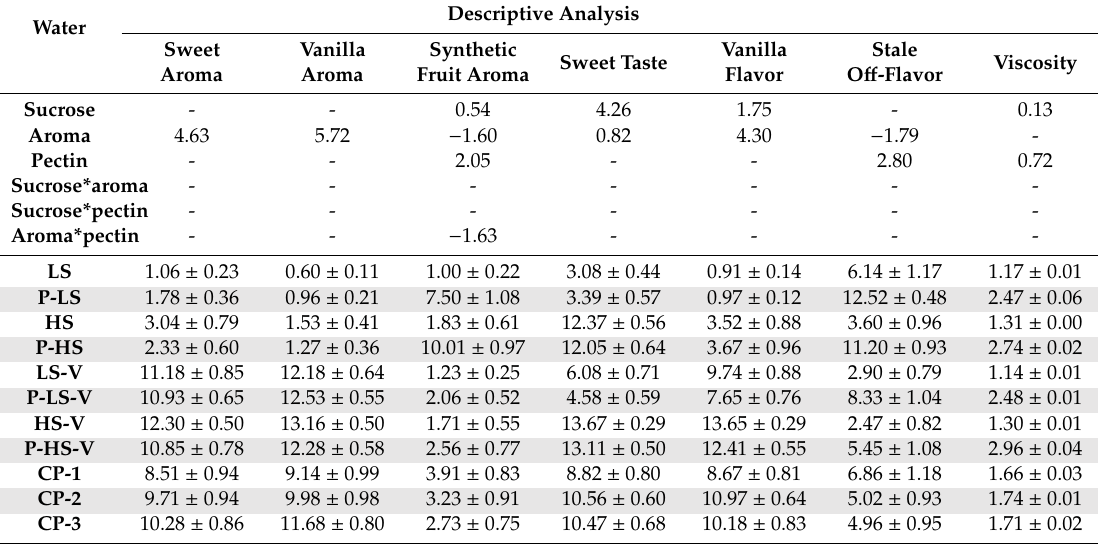
Table 3. Scaled and centered coe ffi cients for significant main e ff ects and 2-way interactions as well as means ± std. error of the mean for the samples in the aqueous matrix. Viscosity means are in cP. Samples are labelled according to Table